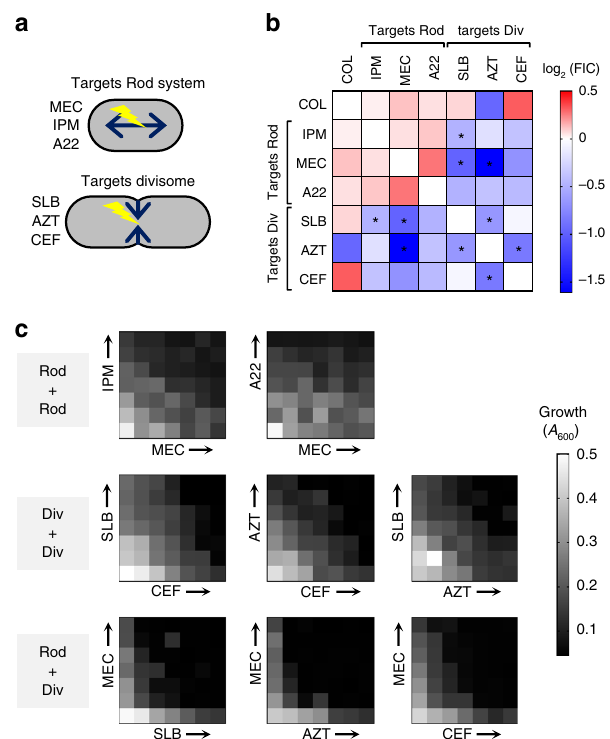
Fig. 6 Synergistic inhibition of A. baumannii by pairing Rod-system- targeting and Divisome-targeting antibiotics. a Diagrams showing the two modes of cell wall growth in rod-shaped bacteria which are governed by distinct biosynthesis systems (Rod-system vs. divisome). Listed next to each diagram is the subset of antibiotics that preferentially target the respective PG synthesis system. b Heat map shows average Log2FIC scores resulting from pairwise interactions among seven antibiotics via the diagonal sampling method from n = 2 independent determinations. Blue indicates synergistic pairs, white indicates additive pairs, and red indicates antagonistic pairs. *Average Log2FIC was signi fi cantly different from 0 in one-sample t test (two-tailed p < 0.05; exact p values shown in Supplementary Table 3). c Validation of drug – drug interactions via checkerboard assay. Heat map shows bacterial growth in microplate wells containing no drug (lower left wells) or increasing amounts of each drug alone or in pairwise combinations. Drug concentrations increase linearly from left to right along x -axis, and bottom to top along y -axis. “ Div ” refers to Divisome, “ Rod ” refers to Rod-system. Source data are provided as a Source Data fi